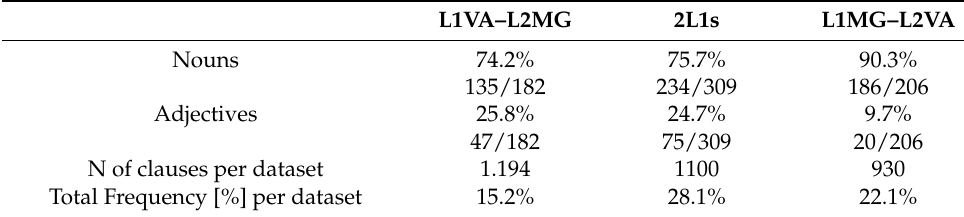
Table 7. Frequency of morphosyntactic integration of VA features on MG lexical items.